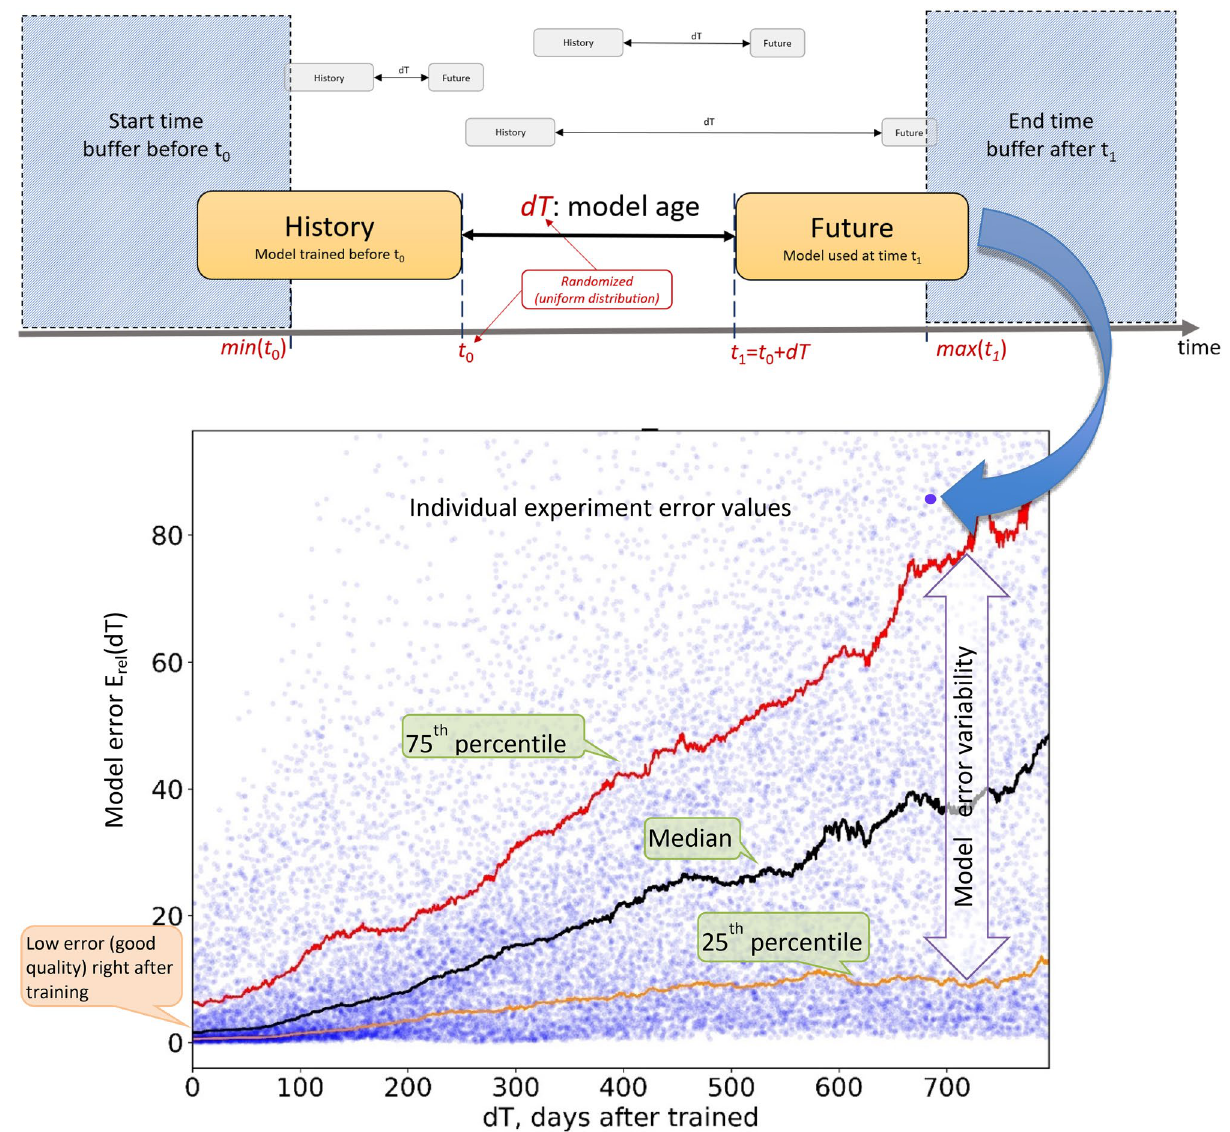
Figure 2. Top: AI temporal degradation experiment, modeling AI model deployment at a random date t 0 . The model is trained on the data (history) available at the deployment time t 0 . Each (Train,Test) pair is generated with uniform random distribution for dT and t 0 , and with Test dataset time starting dT days after the Train dataset ended. Two large time buffers are excluded on each end to ensure truly uniform sampling of dT and t 0 . Bottom: A typical layout of a model aging chart, with each small dot representing the (dT, E rel ) outcome of a single temporal degradation experiment. One can observe the density of the original error distribution (small dots), as well as its principal trends (best-case with 25th percentile, median, and worst-case with 75th percentile). The gap between the best- and worst-case scenarios shows how the model quality variability changes with the model age